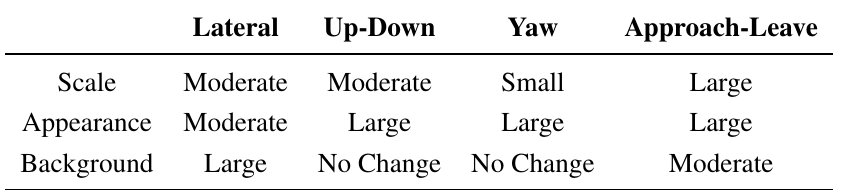
Figure 10. Graphical representation for indoor test videos. There are 4 motion types, namely lateral, up-down, yaw and approach-leave. Each of them is illustrated with the top and camera views. Dashed gray thick lines represent the motion of the camera or the quadrotor along the path with the given length. Dashed black thin lines are used to represent dimensions. Table 2. Properties of motion types in terms of the amount of changes in the scale and appearance of the quadrotor and the background